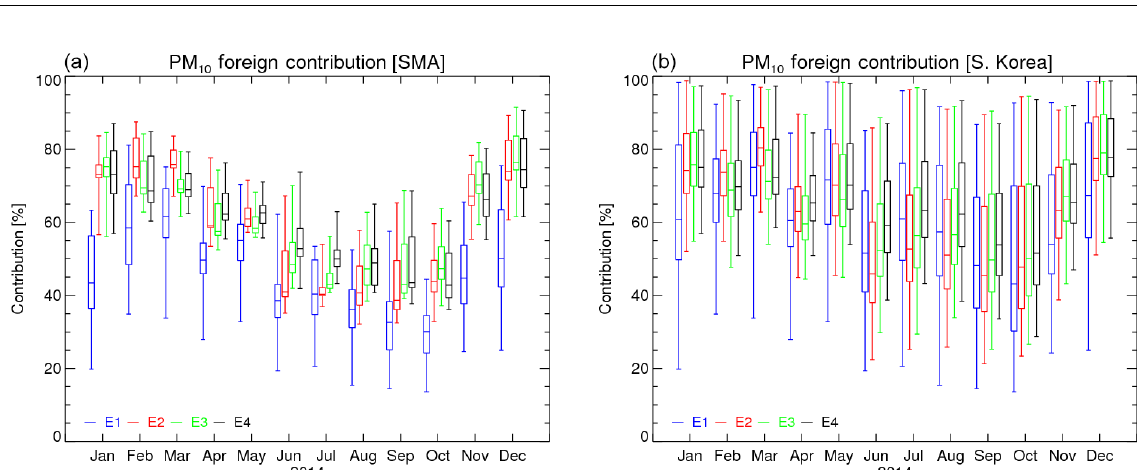
Figure 9. Seasonal variations in foreign emissions contributions to surface PM 10 concentrations over the SMA (a) and over South Korea (b) . Simulation cases E1–E4 indicate emissions inventory combinations as described in Table